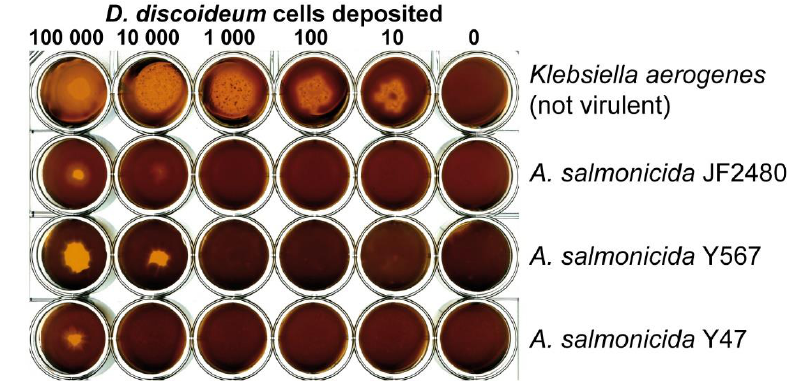
Figure 3. Virulence of strain JF2480 at low temperature. Different numbers of D. discoideum cells were